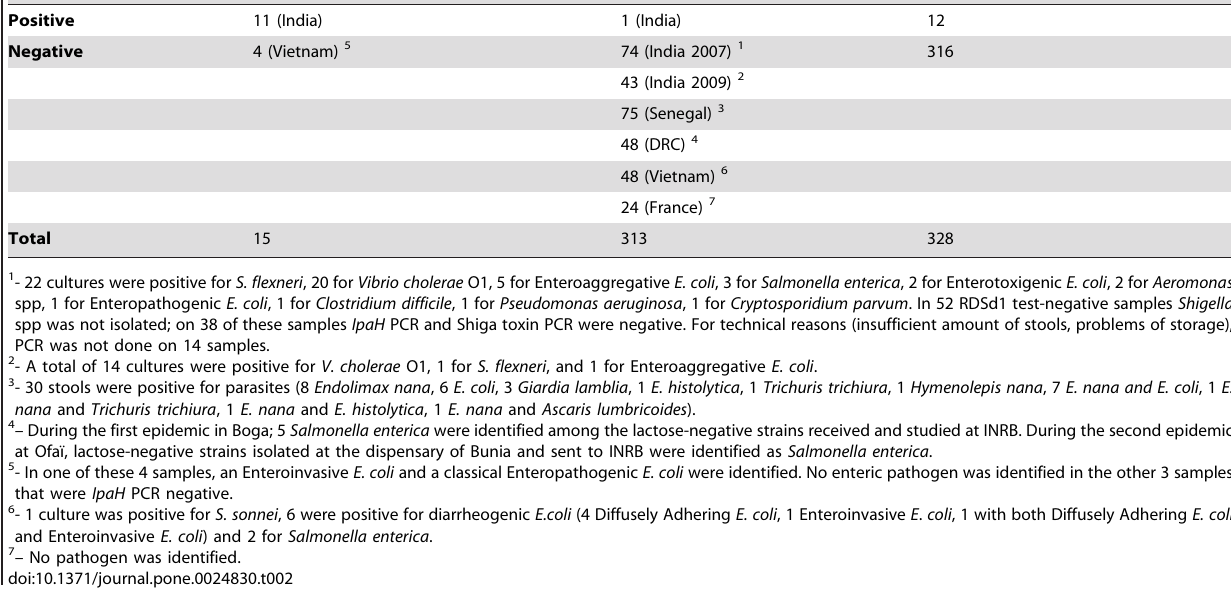
Bacteriological